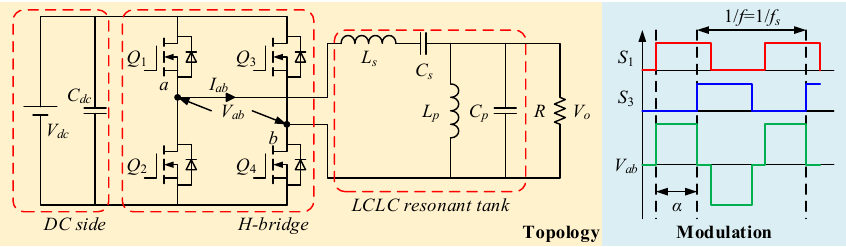
Figure 2. Typical topology and modulation of HFAC LCLC resonant inverter.